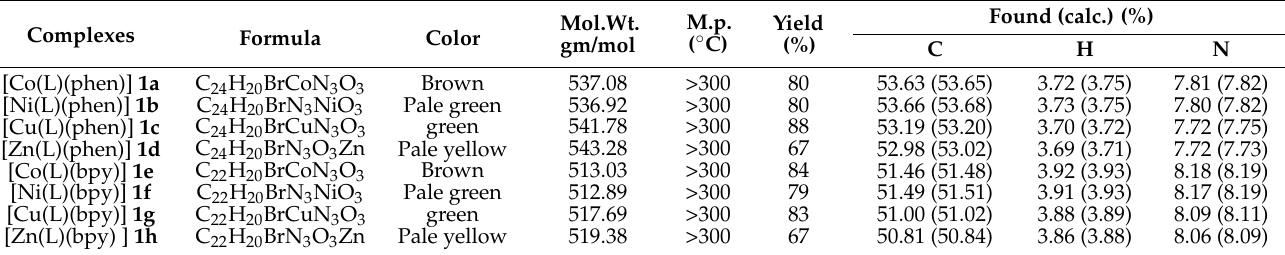
Table 1. Physical and analytical data of metal(II) complexes 1 ( a – h